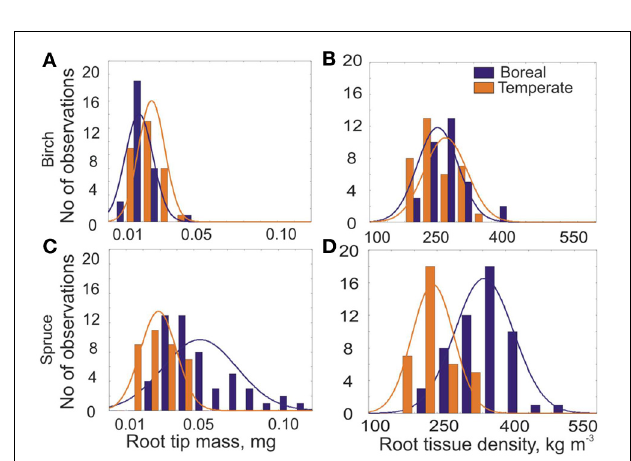
FIGURE 7 | Frequency distribution of (A and C) the mean root tip mass (W, mg) and (B and D) root tissue density of EcM roots (RTD, kg m − 3 ) for two northern birch stands in Siberia (Syktykvar55, Syktykvar30) and for two southern birch stands in UK and Estonia (Risley Moss, Erastvere45) and for two most northern (Kivalo and Pallasjärvi in Finland) and two most southern (Höglwald and Altötting in Germany) spruce sites collected in 2008 (Ostonen et al.,